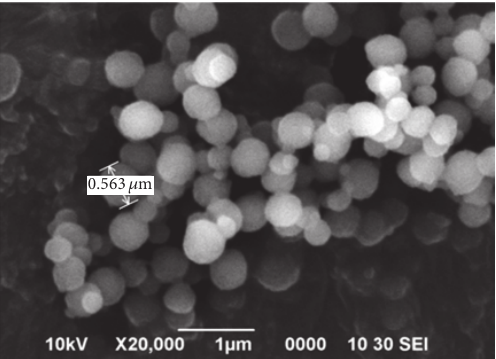
Figure 2: SEM of imprinted polymer particles.